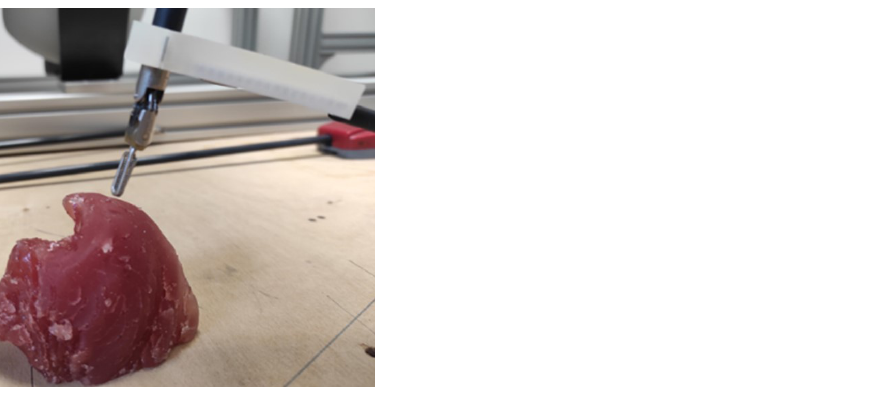
Figure 11. Positioning of the sensing device prototype on the PSM tool of the dVRK system.